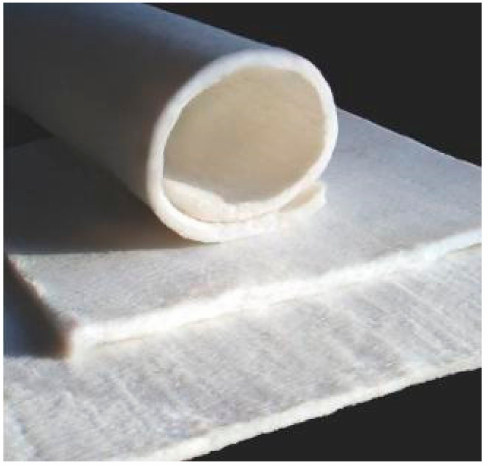
Figure 2. The tested aerogel